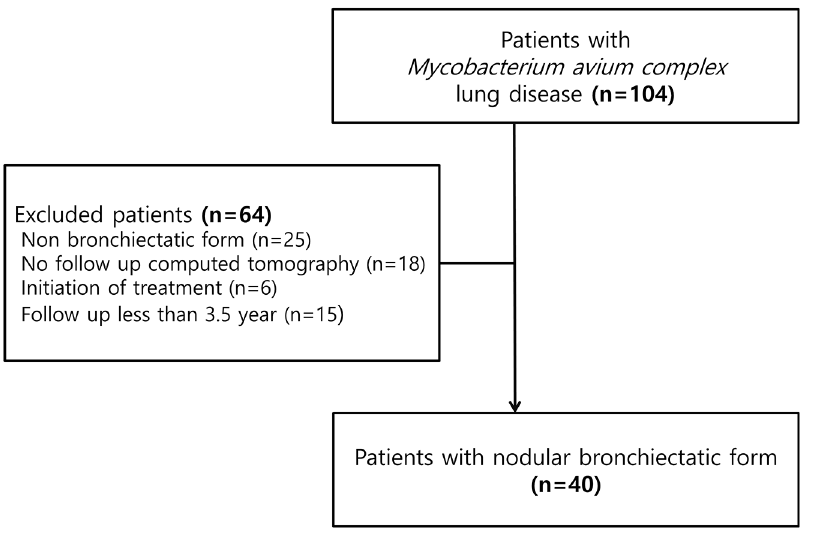
Fig 1. Flow chart of patients with MAC lung